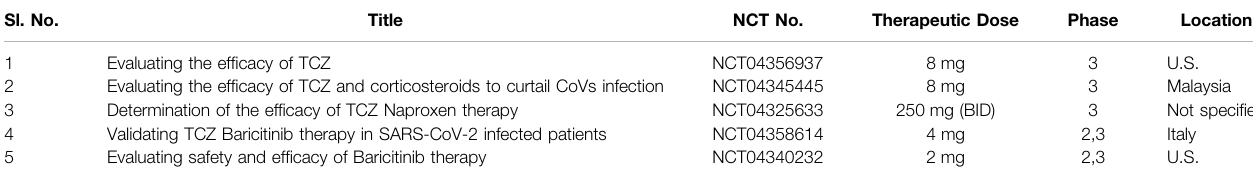
TABLE 7 | Running clinical trial studies for validation of IL-6 Inhibitory drugs (https://clinicaltrials.gov/ct2/results). Sl.